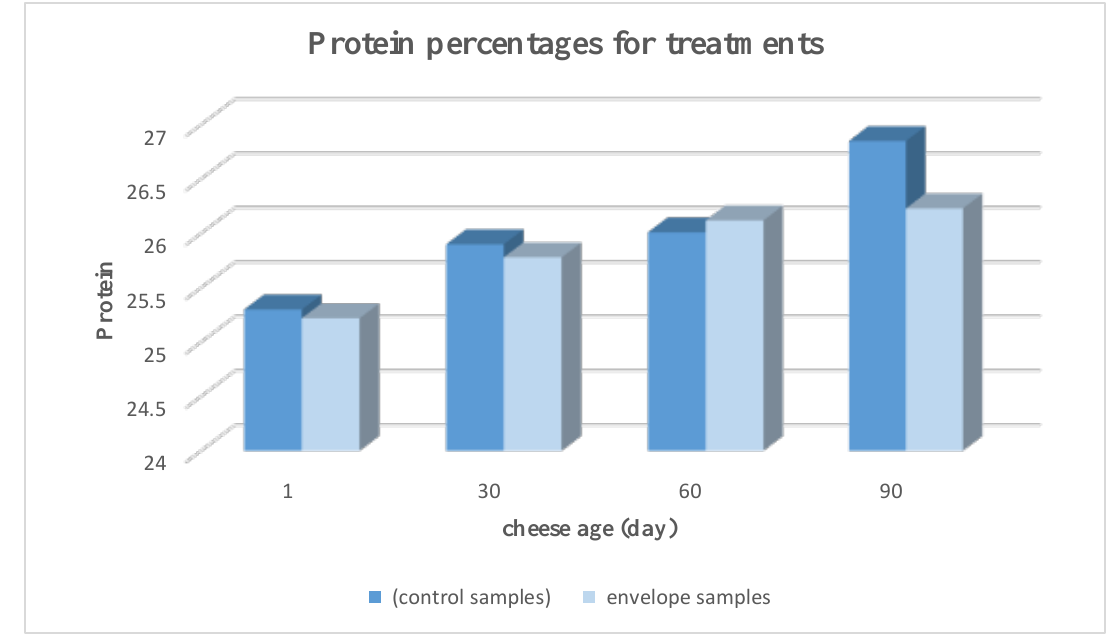
Figure 2: Protein percentages for treatments of unwrapped mozzarella cheese (control sample) and cheese samples coated (enveloped sample) during storage